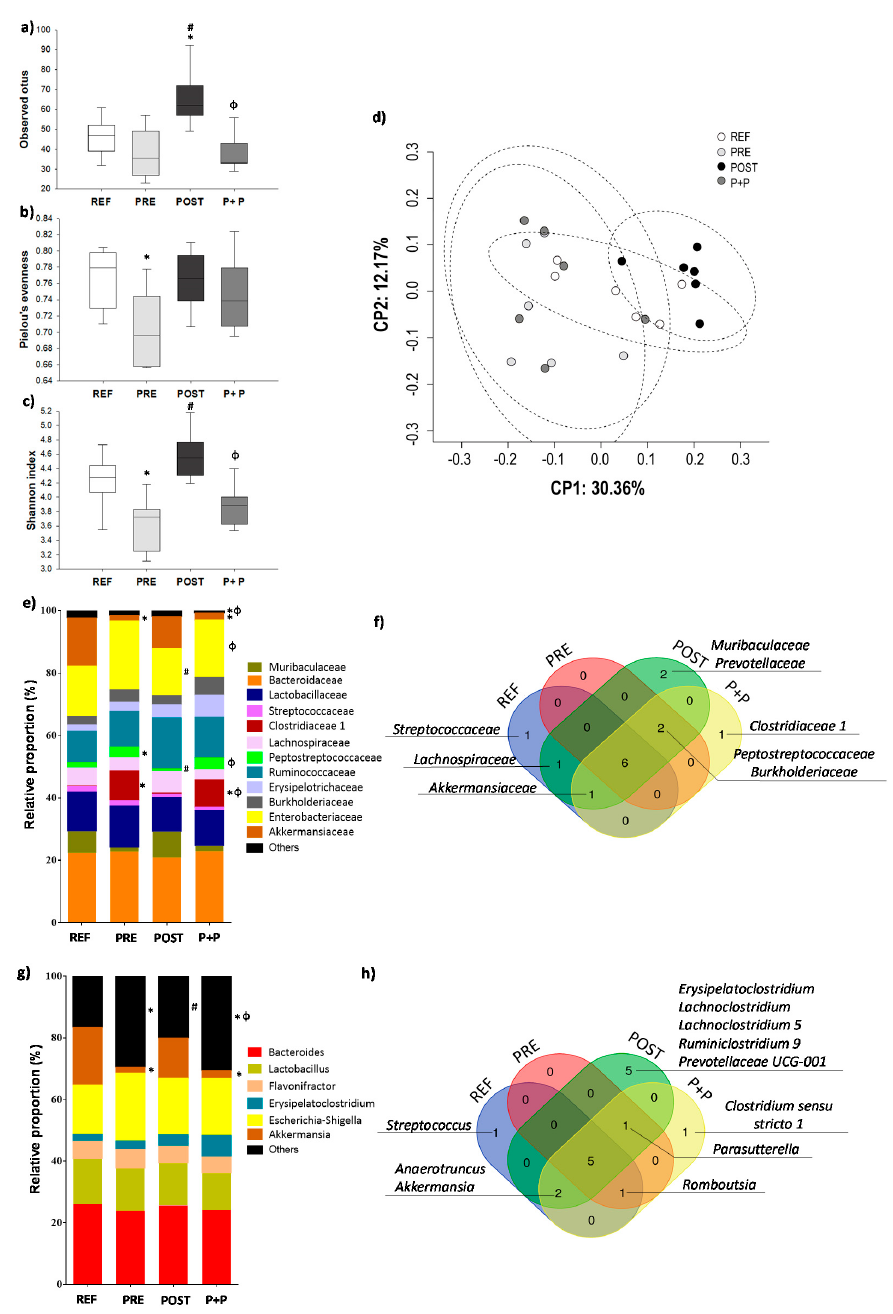
Figure 4. Assessment of cecal microbiota composition. The sequencing of the amplicon targeting the V3-V4 variable region of the 16S rRNA was performed using the Illumina Miseq sequencing 300x2 approach. The alpha diversity is represented by the richness ( a ), Pielou’s evenness ( b ) and Shannon’s indexes ( c ). The beta diversity was calculated measuring the Unweighted Unifrac distance ( d ). The taxonomic abundances of the main groups corresponding to family ( e ) and genera ( g ) are represented in stacked bars. The qualitative assessment of microbiota is represented in a Venn Diagram at the level of family ( f ) and genera ( h ). Results are derived from n = 6 animals/ group. Statistical significance: * p < 0.05 vs. REF, # vs. PRE and φ vs. POST. REF: reference group; PRE: group supplemented with a mixture of scGOS and lcFOS; POST: group supplemented with Lactofidus TM ; P+P: group supplemented with the combination of